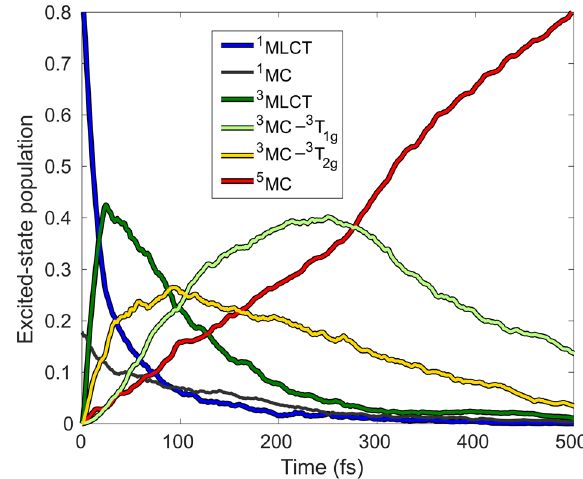
Fig. 3 Simulated excited-state population dynamics of [Fe(terpy) 2 ] 2 + for early times t ≤ 500 fs. The 3 MC population is decomposed to the 3 T 1g and 3 T 2g